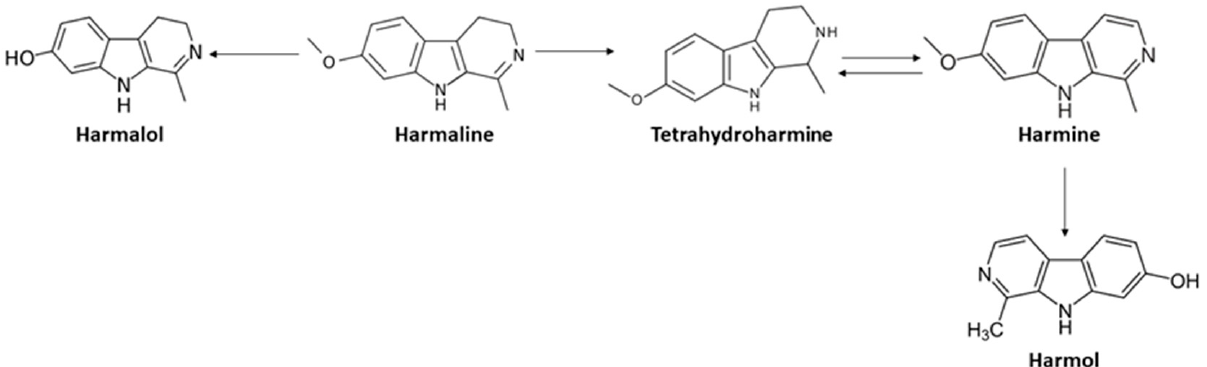
Figure 2. Reactions between β -carboline alkaloids.